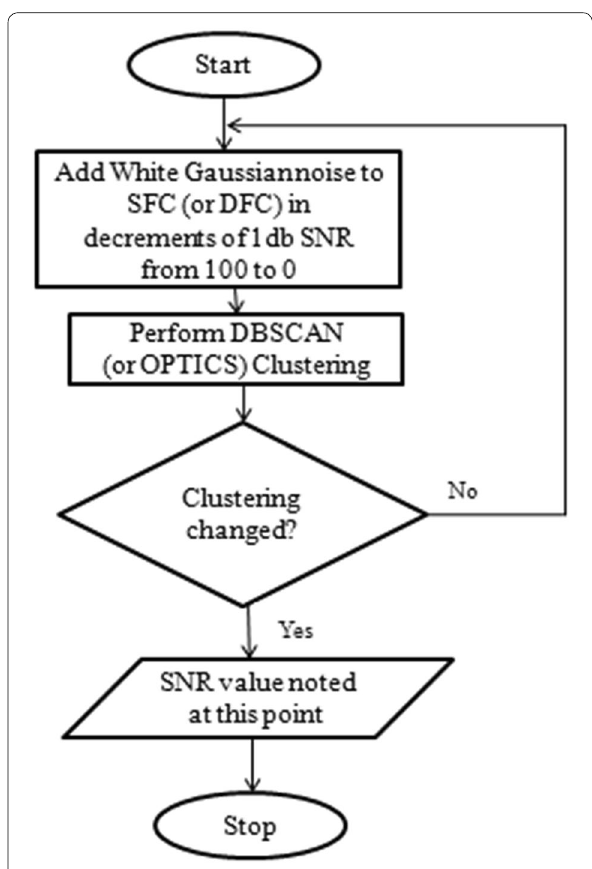
Fig. 2 Flowchart for assessing robustness using additive noise